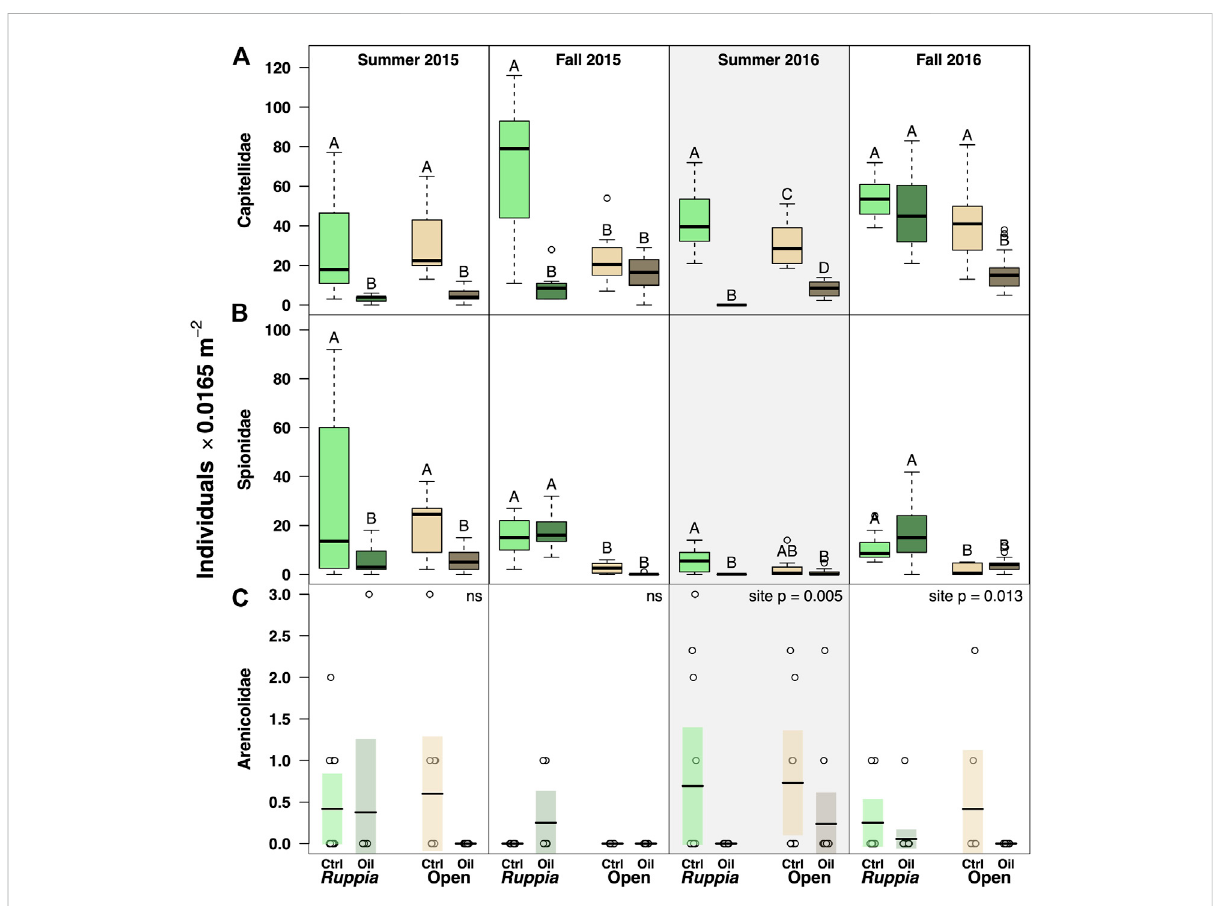
FIGURE 4 Abundancedataforfamiliesthatshowednegativeresponsestooiling(allhereareinphylumAnnelida).TheSummer2016panelsarehighlighted to emphasize the reoiling event observed at that time. For panels (A,B) , boxes with different letters are different by Tukey post-hoc tests. Arenicolid data (C) was heavily dominated by 0 values, making boxplots inappropriate visualizations – instead, we are showing raw data (circles) overlaid with means (horizontal bars) and 95% con fi dence intervals for the mean (shaded rectangles; in cases where no 95%CI is visible, all abundances were ‘ 0 ’